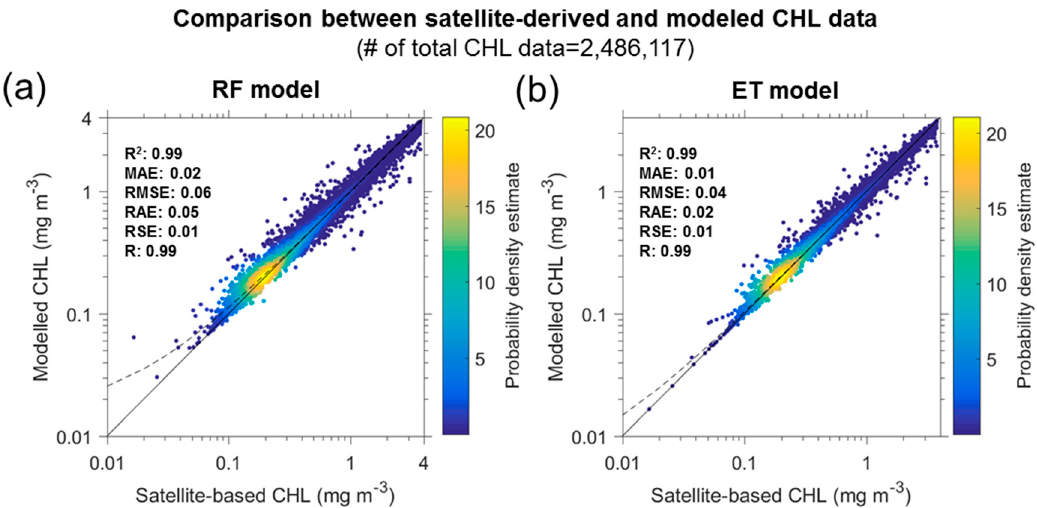
Figure 5. Density scatters plot of 2,486,117 data comparing between the satellite-based and modeled CHL in: ( a ) RF and ( b ) ET. The CHL is expressed in a logarithmic scale, and the color represents a probability density estimate. The black solid and dashed lines are one-to-one correspondence and linear regression lines on a log scale, respectively.